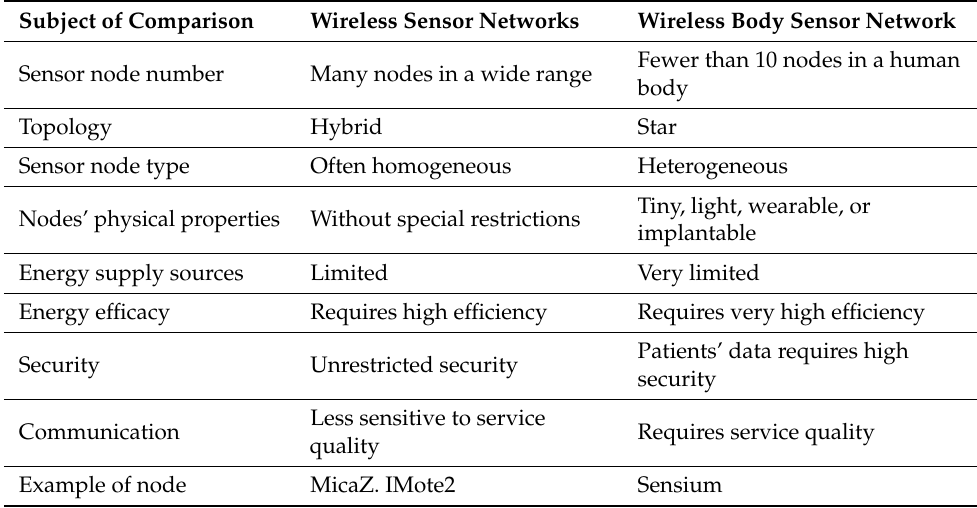
Table 3. Comparison between WSN and WBAN sensors